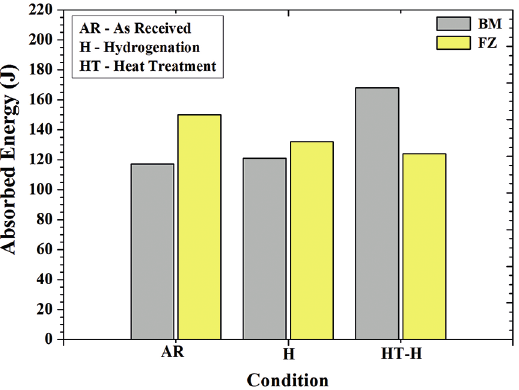
Figure 7: Absorbed energy of specimens subjected to different treatments.